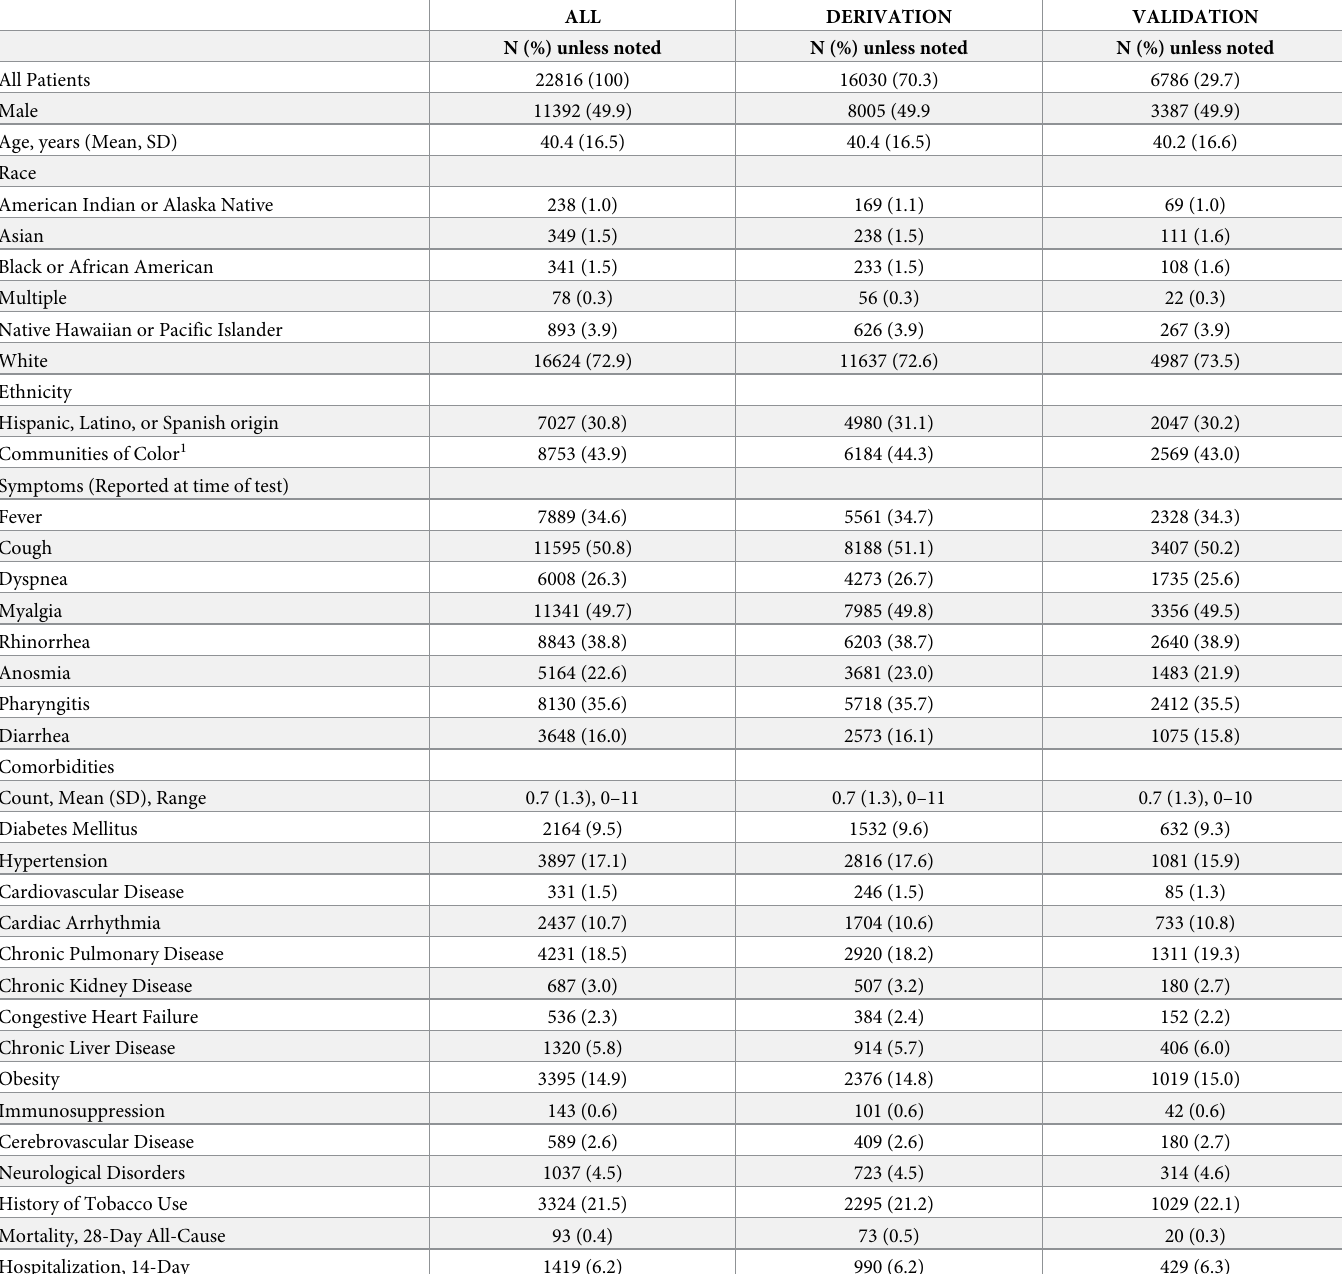
Table 1. Patient characteristics, total and by derivation and validation cohort groups. ALL DERIVATION